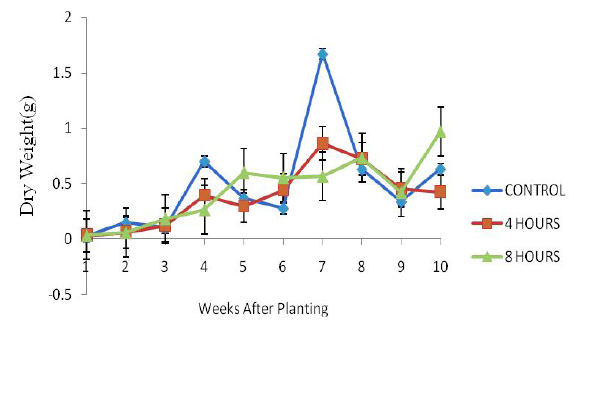
Fig. 4. Effect of prior heat stress on the dry weight of C. papaya The accumulation of chlorophylls a, b and total chlo- rophyll in the plants did not follow a particular trend as can be seen in Figs. 5, 6 and 7. The results of the ANOVA analysis showed that there was no significant difference in chlorophylls a, b and total chlorophyll in the different heat treatments.